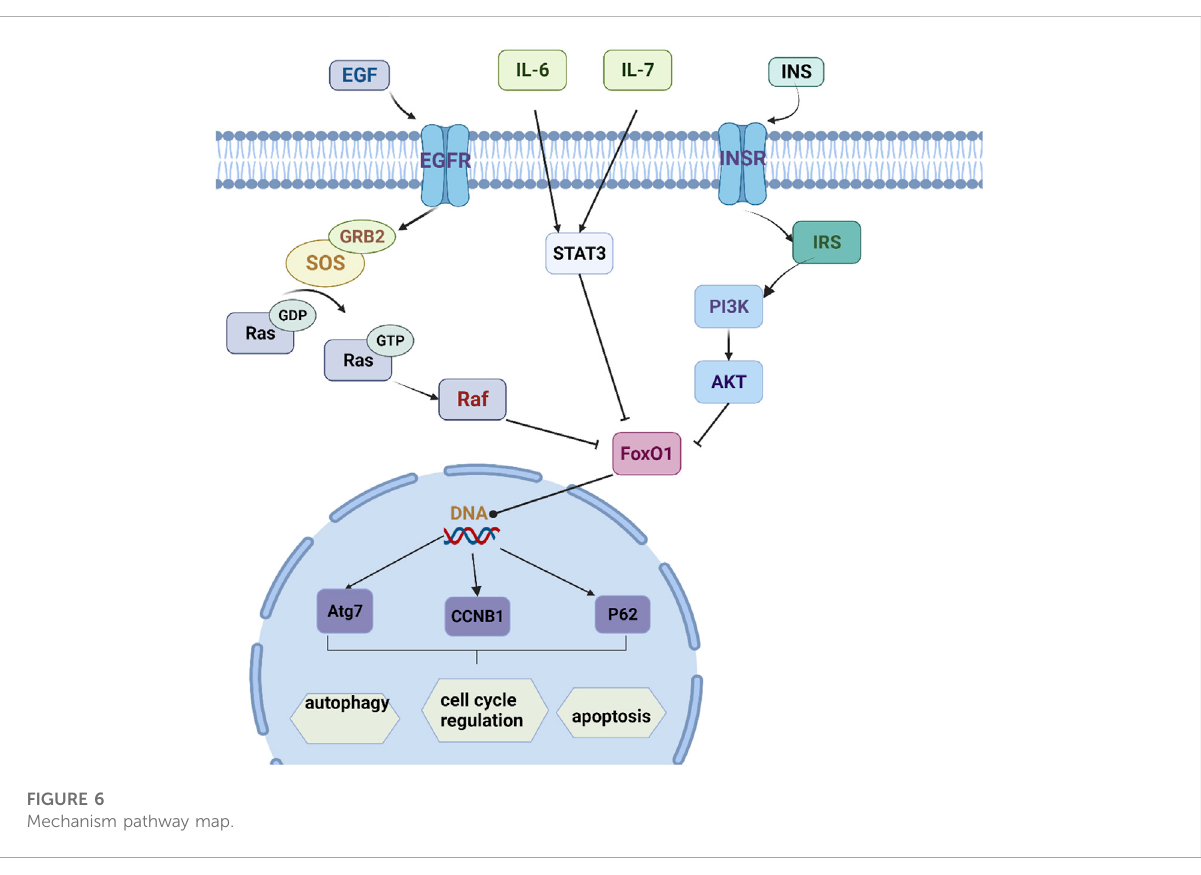
FIGURE 6 Mechanism pathway map.